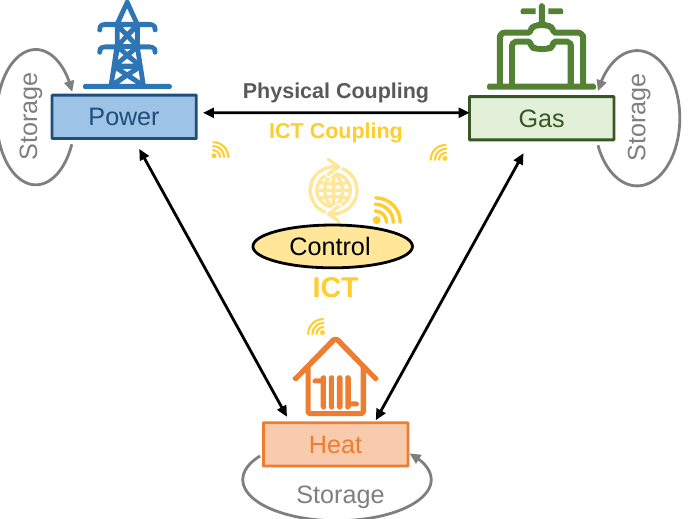
Figure 1. Physical and ICT coupling of energy